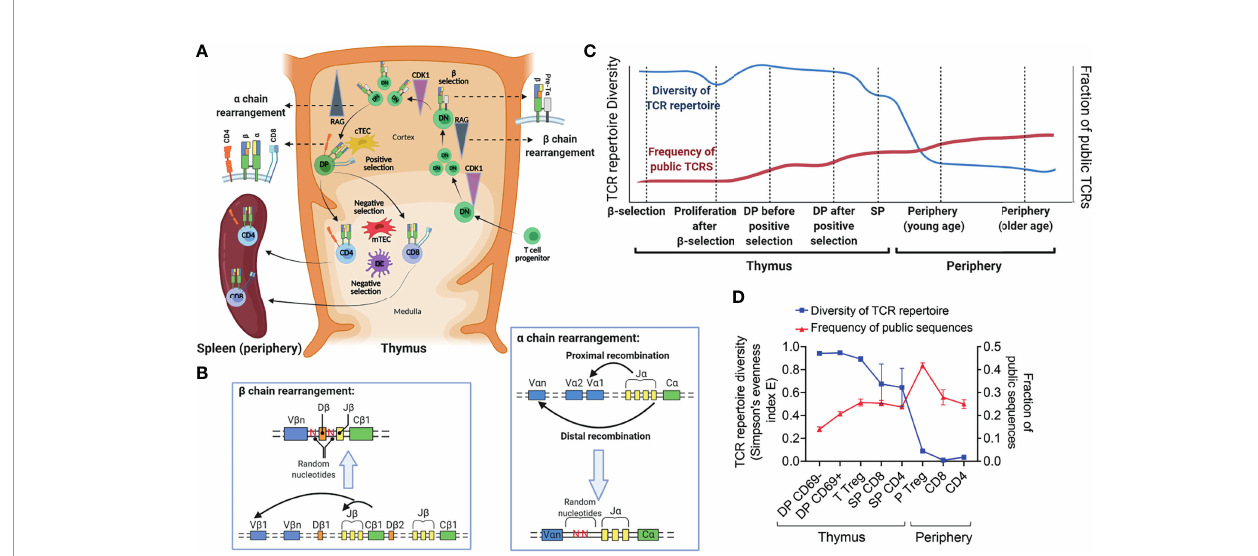
FIGURE 1 | TCR repertoire formation in human thymus and periphery. (A) Schematic presentation of different stages of T cell development in human thymus and periphery. (B) TCR b and a chain rearrangement processes. (C) Hypothetical changes in “ TCR repertoire diversity ” and “ frequency of public TCRs ” through different developmental stages. (D) Kinetics of changes in the diversity of TCR b repertoire, as measured by the Simpson ’ s evenness index E, and fraction of public sequences in different subsets of human T cells from the thymus and periphery of HIS mice generated by transplantation of human thymocyte-depleted fetal thymus tissue and fetal liver HSCs into immunode fi cient NSG mice (n=2-7). Public sequences were de fi ned as TCR b CDR3 sequences that were repeated between different mice or different cell subsets (19). This fi gure was created with